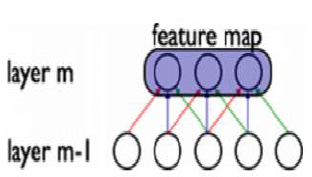
Figure 6: Shared weights Colour identifies the weight The last characteristic is pooling, which is a form of down sampling. Pooling means aggregate features in a rectangle